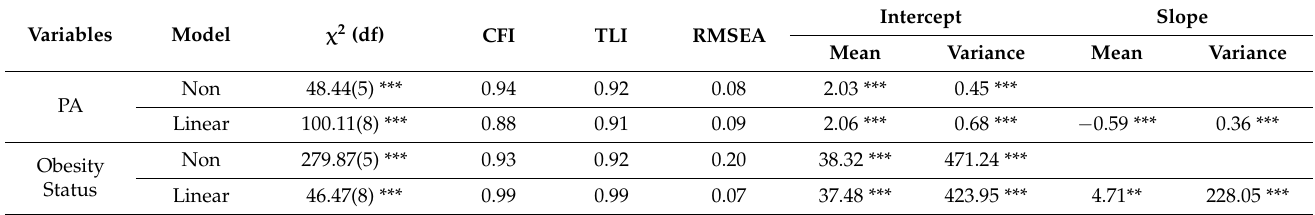
Table 2. Model fitness